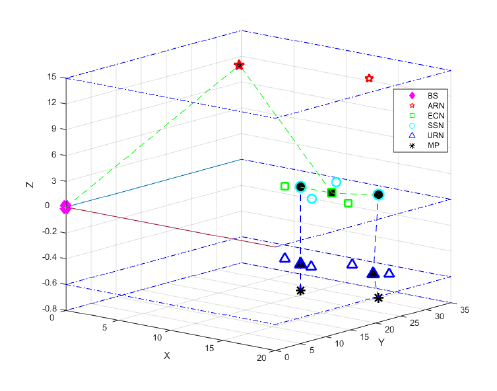
Figure 4. The optimal solution of Scenario ( C net = 68 gcu, E max = 8.18 × 10 − 5 %).